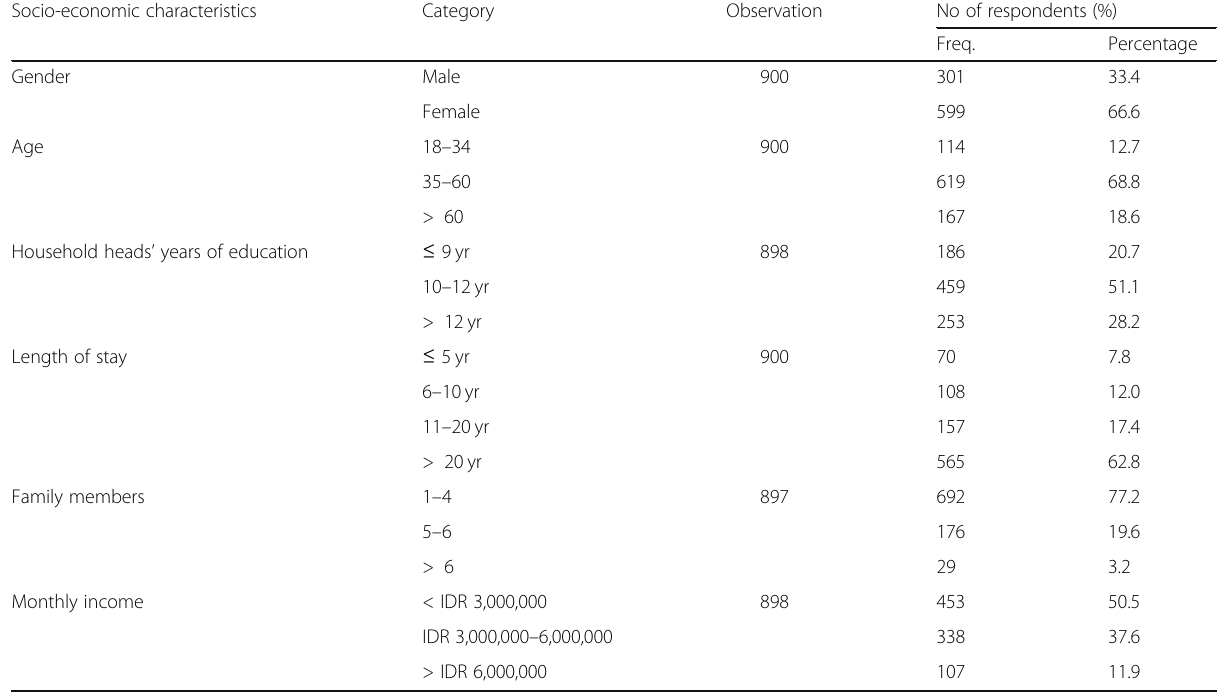
Table 2 Descriptive statistics of socio-economic characteristics of the respondents Socio-economic